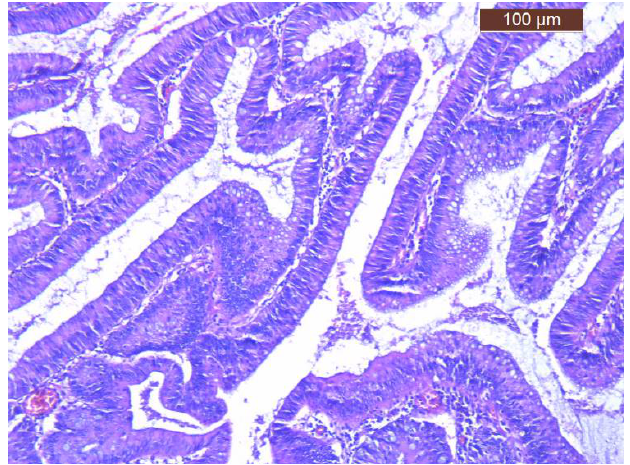
Figure 5. Histology of resected specimen (tubulo-villous adenoma with low-grade dysplasia and several foci of high-grade dysplasia).